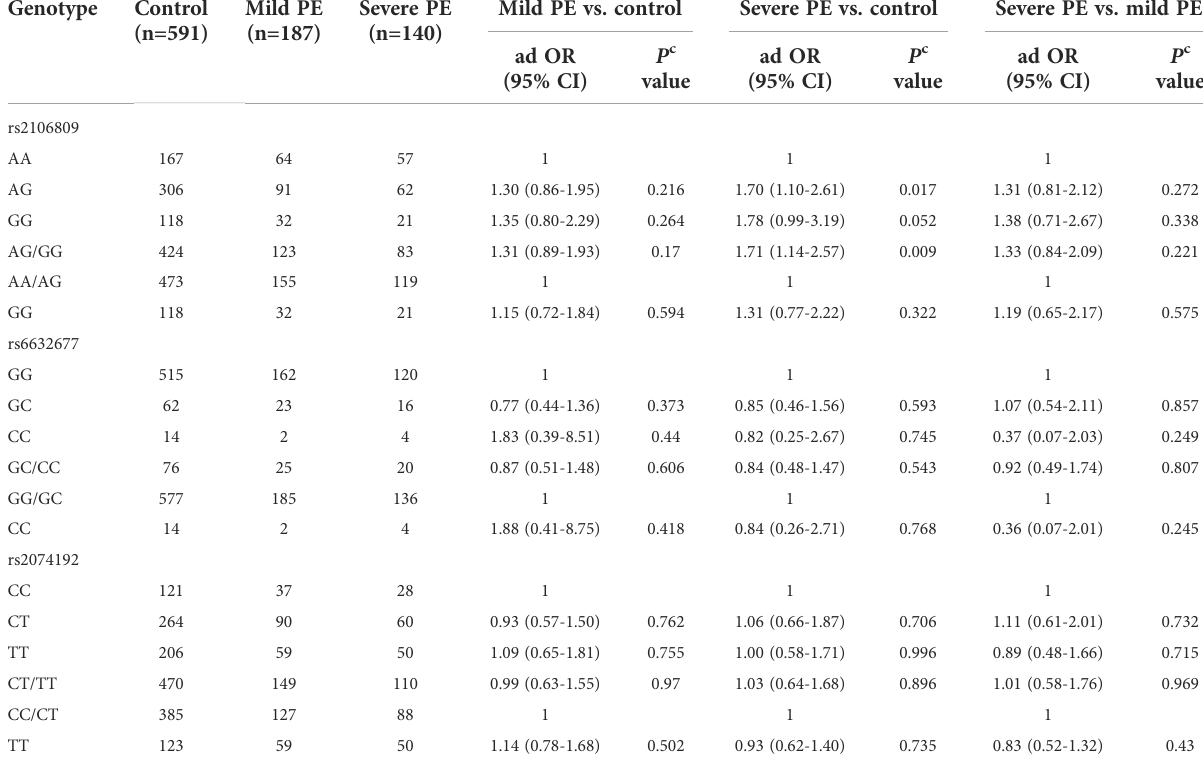
TABLE 5 Association between genotypes of selected SNPs and PE risk of different severity. Genotype